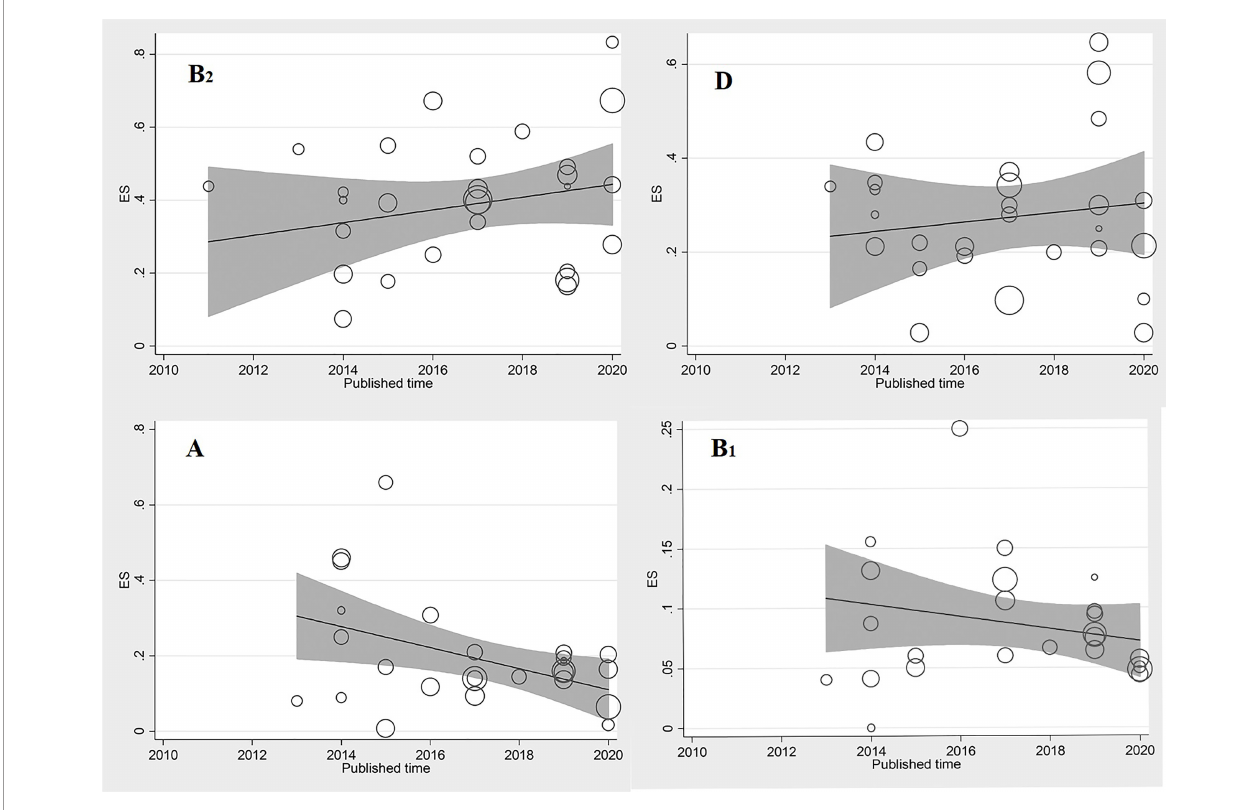
FIGURE 7 | Meta regression of the log-event rates by year (phylogroups B 2, D, A, and B 1